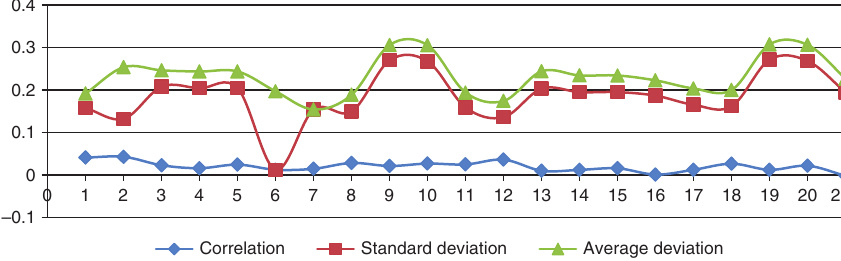
Figure 2: Overall Results for Proposed 21 Measures with MSR Paraphrase.